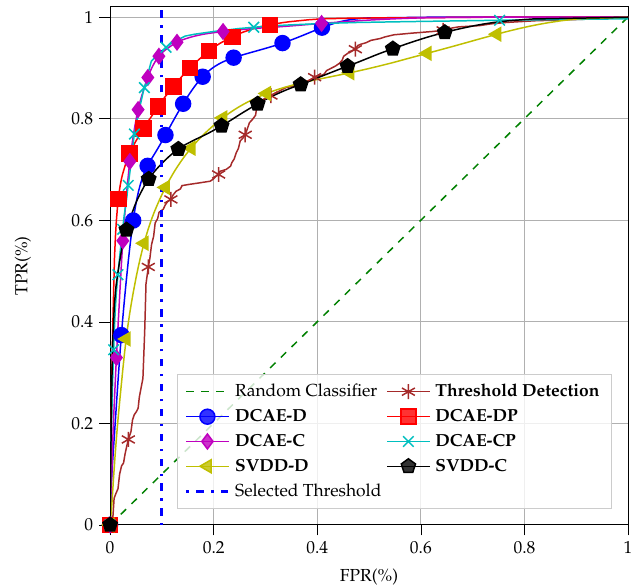
Figure 12. ROC curve of the methods with N On = 300 in the two environments on average.